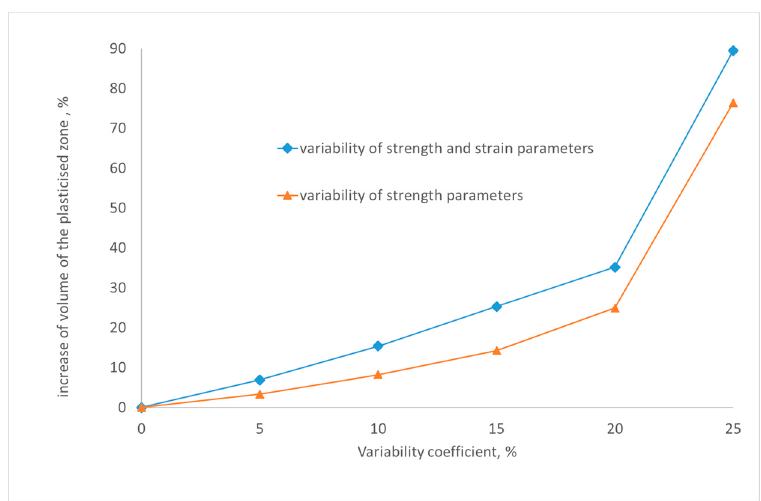
Figure 10. The correlation obtained in the numerical model between the volume of the plasticized zone and the variability coefficient of the mechanical parameters of rocks.